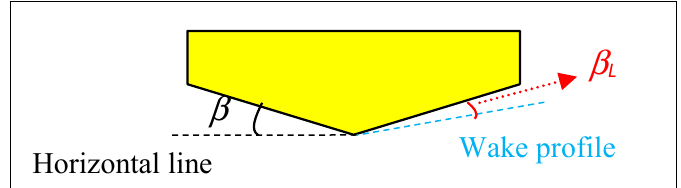
Figure 3. The deadrise angle of the stepped hull.